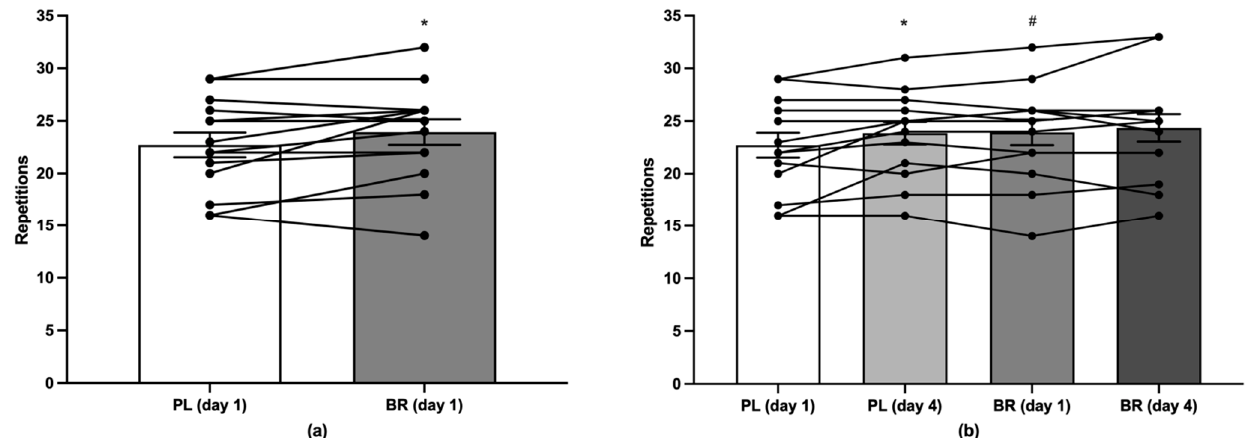
Figure 2. Data are means ± SE of the number of repetitions-to-failure (RTF) during bench press exercise ( a ) on day 1 between conditions and ( b ) on day 1 and 4 between conditions; RTF for individual participants shown in black lines. * = significantly different compared to day 1; # = significantly different compared to PL day 1; BR = NO 3 − -rich beetroot juice; PL = NO 3 − -depleted beetroot juice.